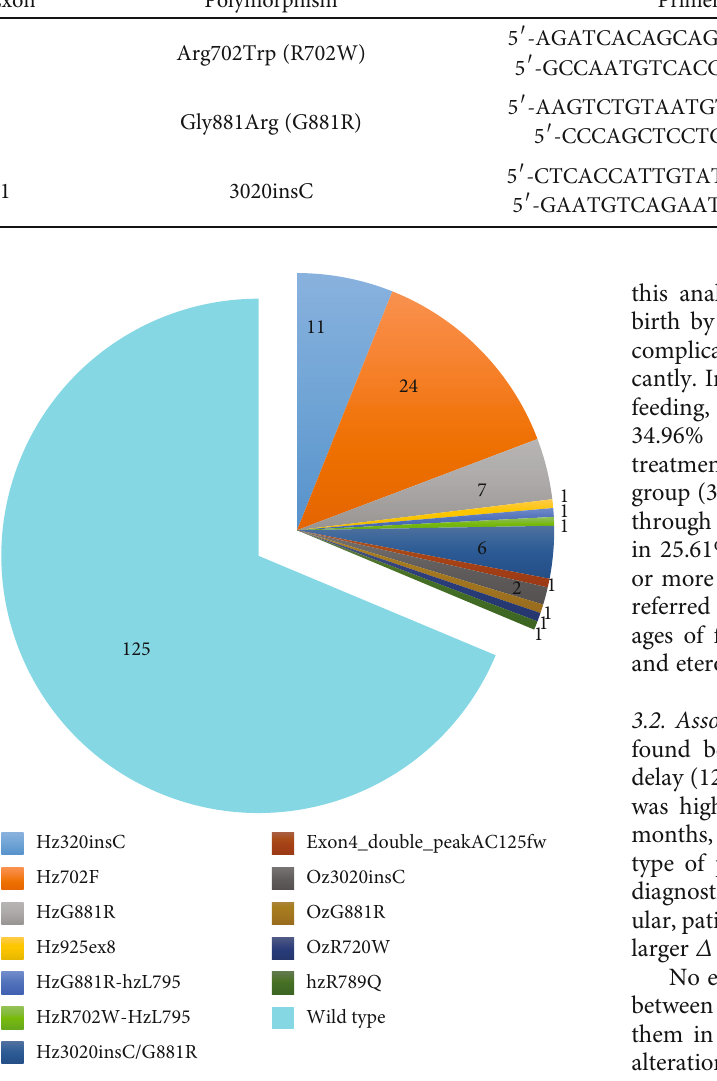
Figure 1: Genotype distribution of the clinical sample population. The fi gure shows the distribution of CARD15/NOD2 genotypes detected in the examined cohort of surgical patients (number of